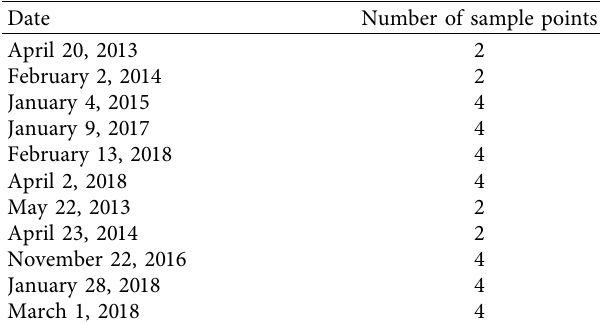
Figure 1: Study area. Table 1: Collection time of sample